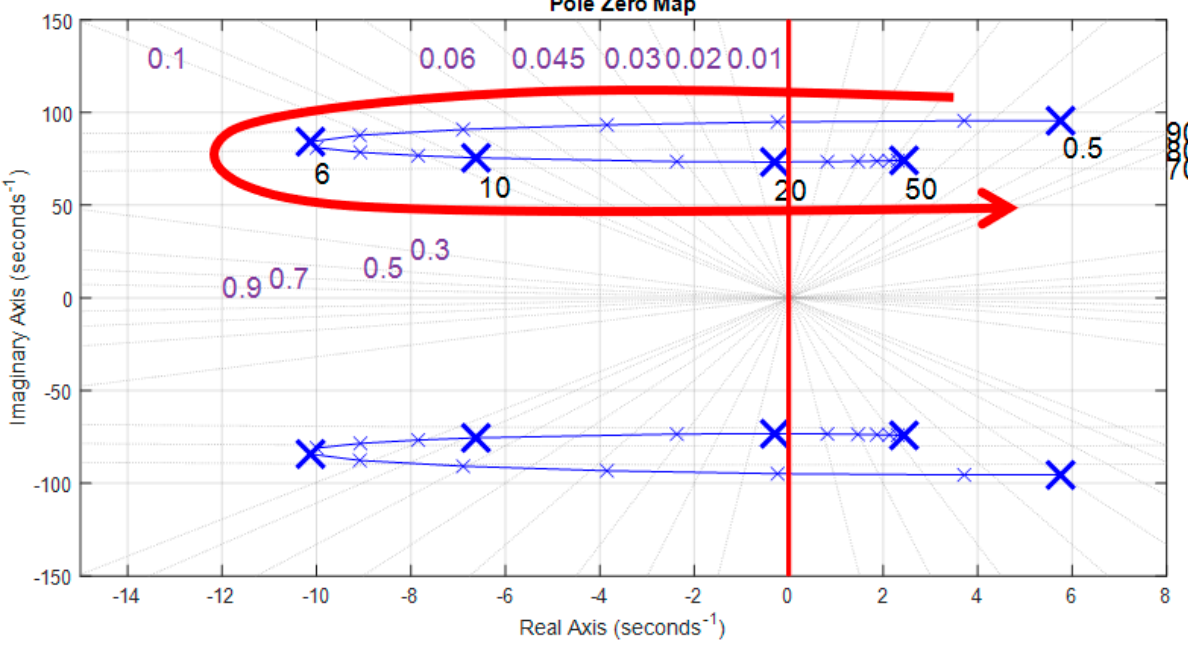
Figure 13. Small-signal model-based root locus with respect to the gas turbine control dynamic (blue crosses) with a bandwidth varying between 0.5 and 50 Hz (with a constant speed of 400 rpm).